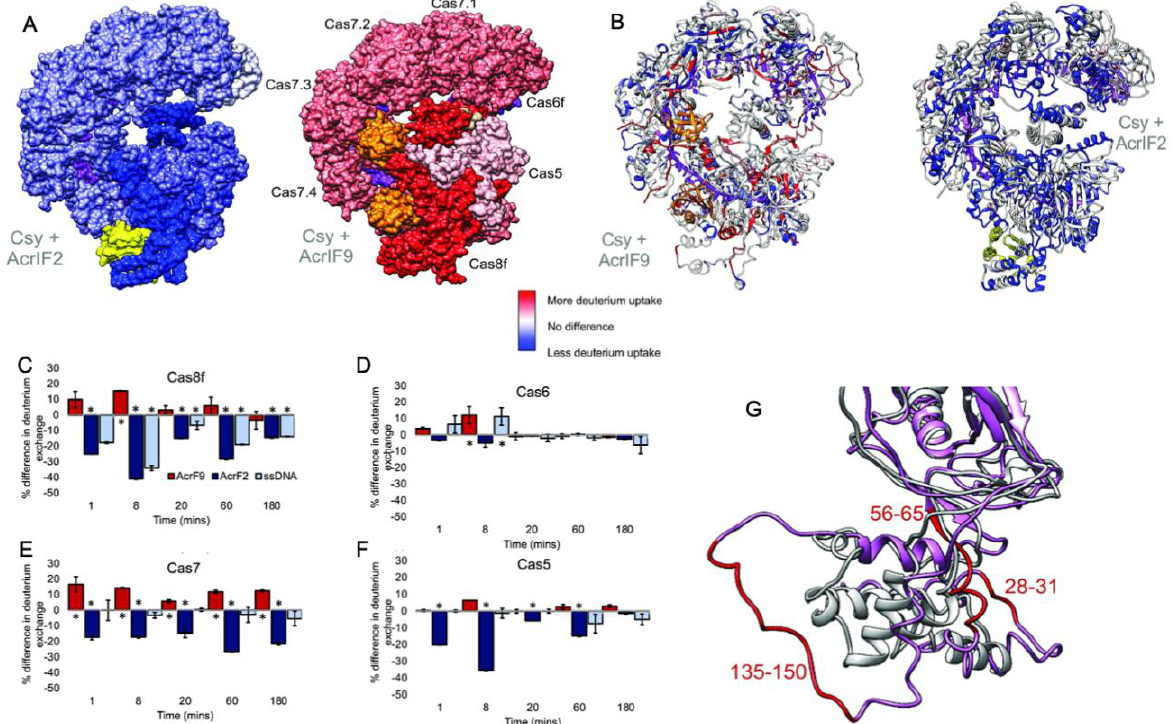
Figure 3. Dynamics of the multi-Cas Csy complex induced by Acrs. ( A ) Intact HXD map of total deuterium exchange in the Csy complex bound to AcrIF2 (left) and AcrIF9 (right), relative to the apo Csy complex. Structures are heat mapped according to the legend. AcrIF2 is shown in yellow, AcrIF9 in orange, and crRNA is shown in purple. ( B ) Peptide level HDX monitoring specific regions within the Cas subunits affected by Acrs. Structures are heat mapped according to the same legend. Generally, strong dynamic perturbations to the Csy complex occur proximal to the AcrIF2/9 binding sites. ( C – F ) Differences in deuterium uptake for various Csy subunits in the presence of AcrIF2